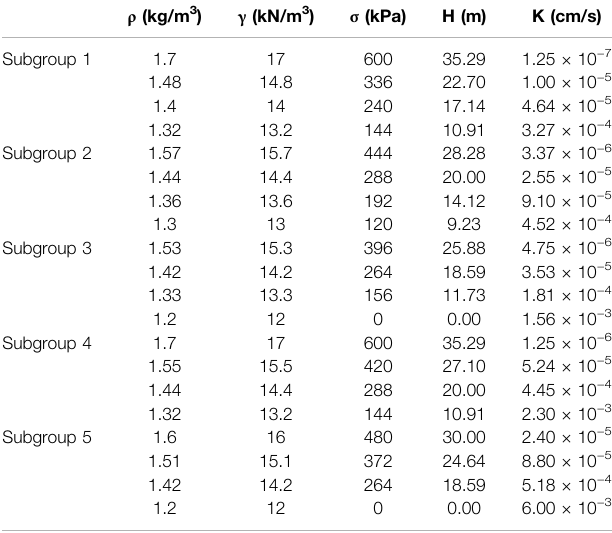
TABLE 3 | Results of permeability analysis for each subgroup of ML